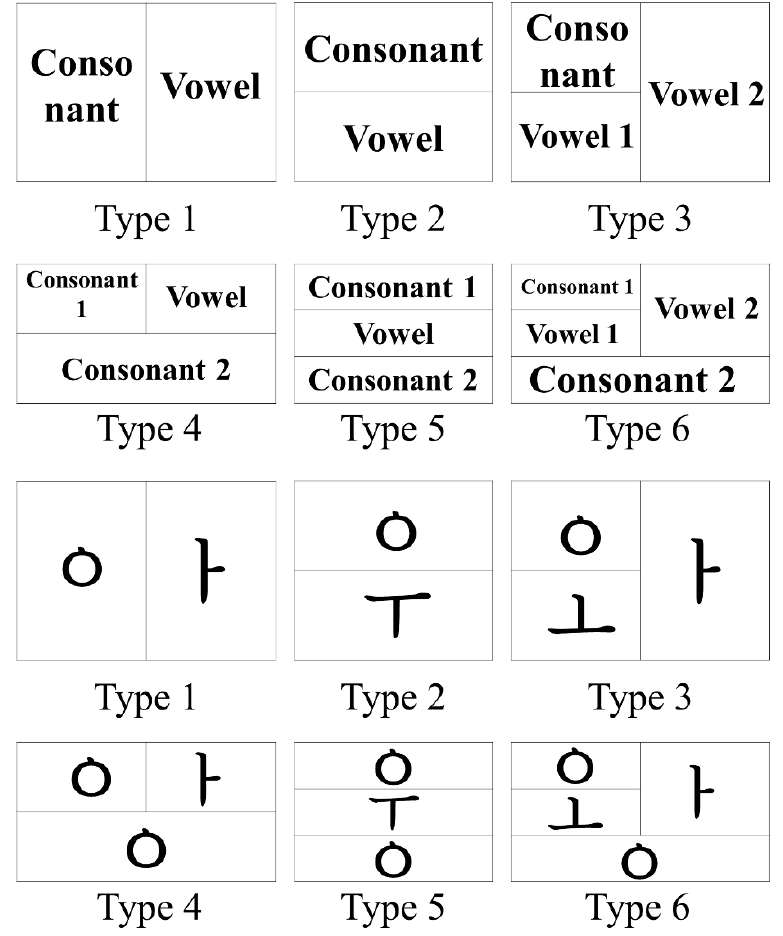
Figure 2. Six types of consonants and vowels in Hangul.